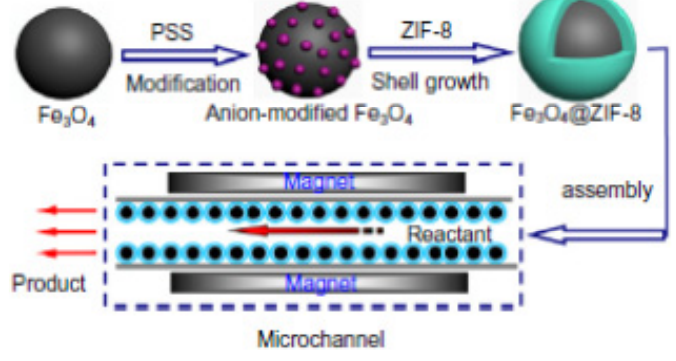
Figure 3. Schematic presentation of the preparation of Fe microspheres and their use as catalysts in a magnetic capillary reactor. Reproduced from [53]. Copyright 2013 with permission of Elsevier.